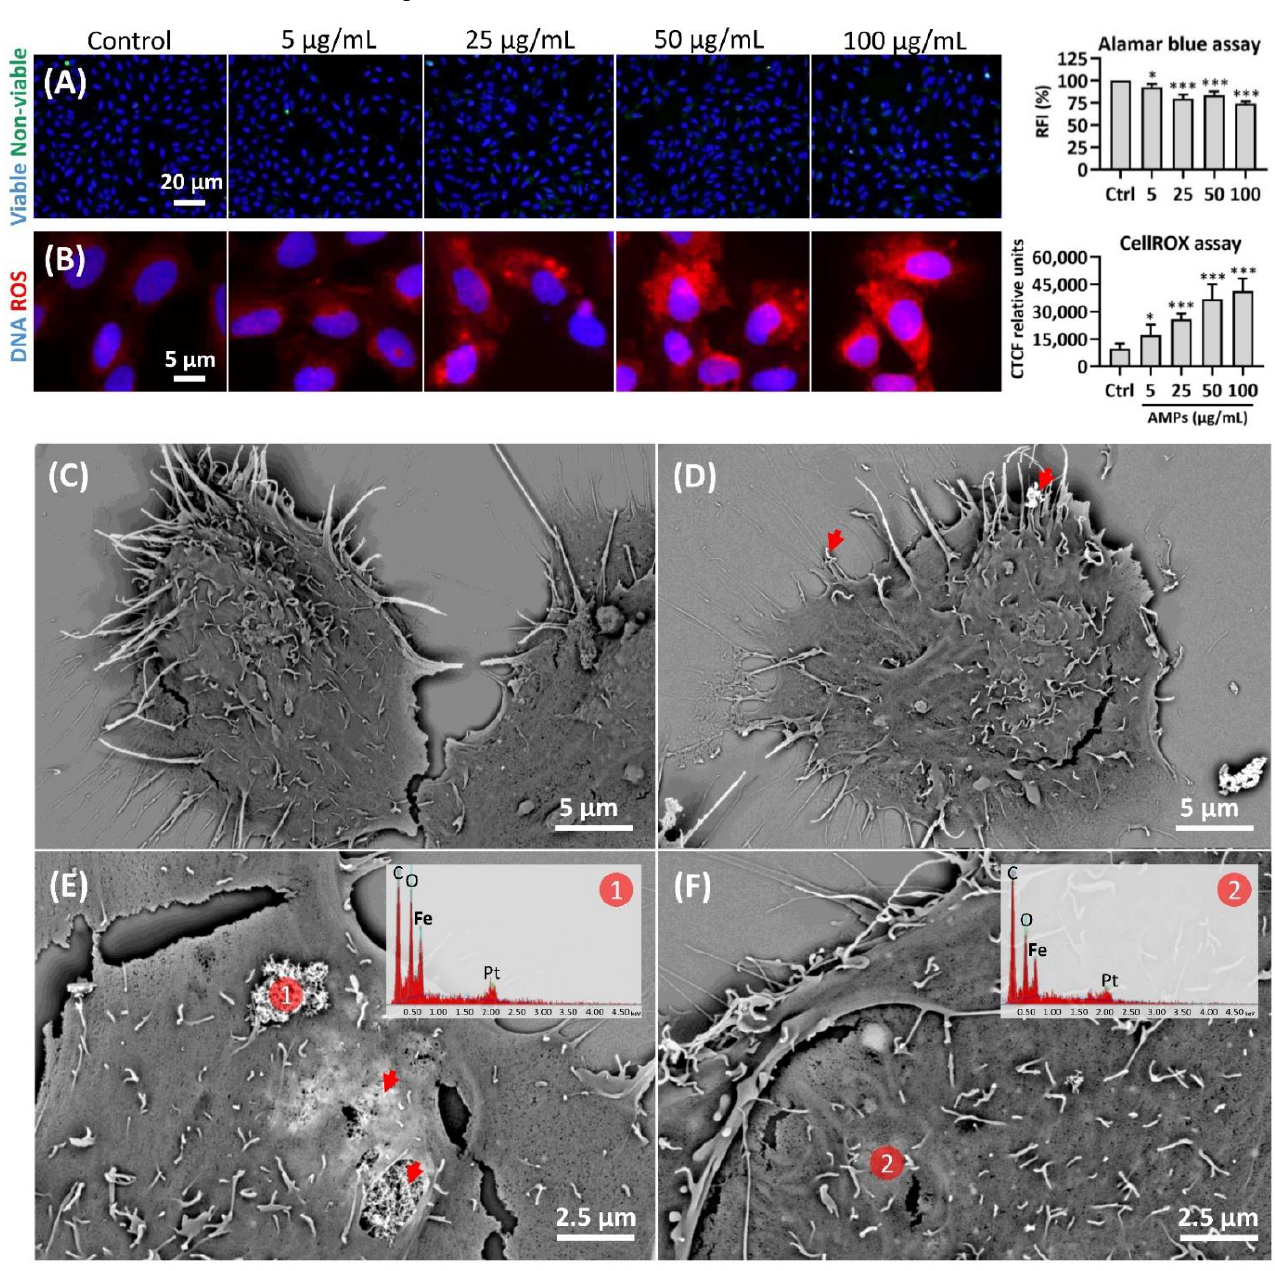
Figure 3. Impact of the (nano)particles unintentionally emitted at the metal AM occupational settings (AMPs) on the cell viability/metabolic activity, ROS production, and internalization . Plate-based assays with the U-2 OS cells exposed to a range of AMP concentrations (0 – 100 µg/mL) discloses that: ( A ) AMPs did not impair the cell viability (blue color — Hoechst 33342 labelling viable nuclei; green color — Image-iT DEAD Green viability stain labelling unviable nuclei), however, AMPs reduced the metabolic activity of cells, as shown in the Alamar blue assay (graph on the right). RFI — relative fluorescence units; ( B ) AMPs induced the ROS production and exerted oxida- tive stress in the exposed cells (blue color — Hoechst 33,342 nuclear labelling; red color — CellROX Deep Red ROS labelling). The graph on the right is a quantitative summary of the relative fluores- cence obtained from the cells after the ROS labelling. The fluorescent signal was quantified using ImageJ software and the data is reported as the mean value of N = 150 cells, per condition. CTCF — corrected total cell fluorescence. * p < 0.05; *** p < 0.001. ( C ) Unexposed U-2 OS cells observed under the scanning electron microscope (SEM) at 10,000× magnification. ( D – F ) U-2 OS cells exposed to 50 µg/mL AMPs for 24 h and imaged under SEM. Red arrows indicate the AMP aggregates/agglomer- ates associated with the cell ’s outer surface ( D ) or partially covered by the cell membrane ( E ). Energy dispersive spectroscopy (EDS) spectra in the upper right corners ( E , F ) indicate the composition of the electron-dense AMP areas. Pt — platinum.